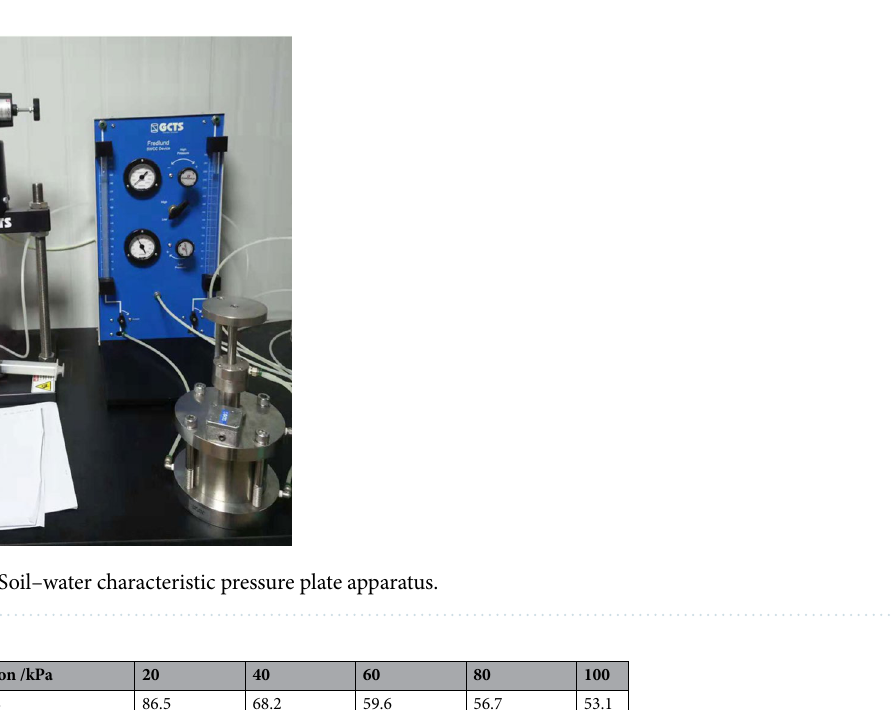
Figure 5. Color-added map: The corresponding colors of seven different elements were added seven different colors on the base map.